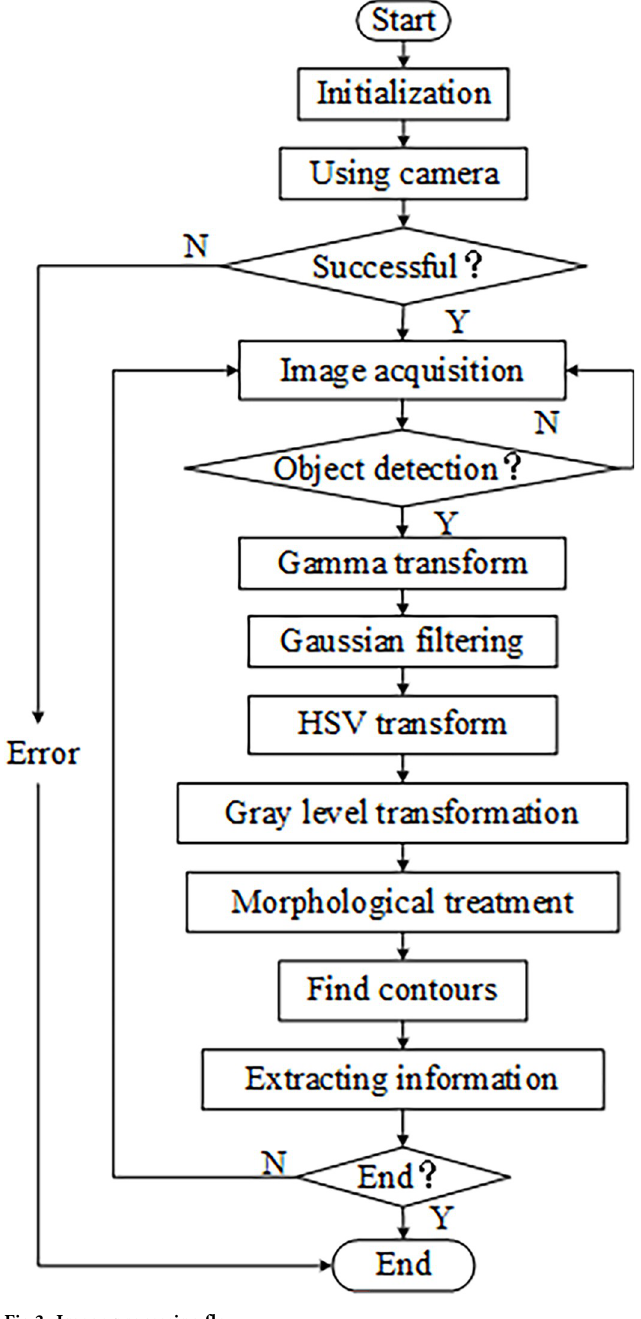
Fig 3. Image processing